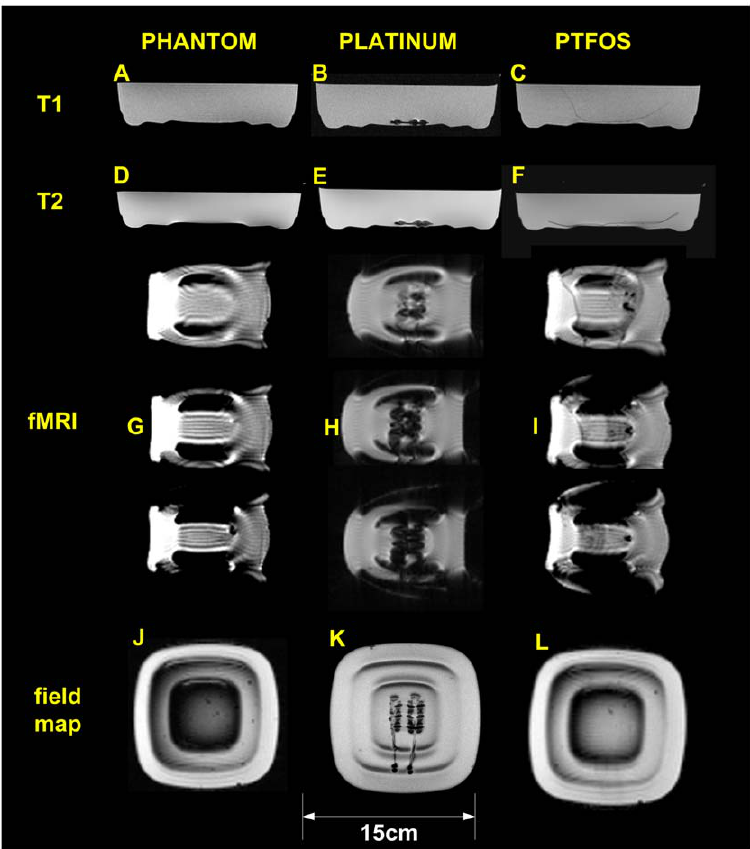
Figure 3. The Magnetic Resonance Imaging testing. T-1 weighted MPRAGE of the: ( A ) phantom only, ( B ) Platinum subdural grid and ( C ) PTFOS. T-2 weighted MPRAGE of: ( D ) phantom only, ( E ) Platinum subdural grid and ( F ) PTFOS. Three consecutive central slices of BOLD images of: ( G ) phantom only, ( H ) Platinum subdural grid and ( I ) PTFOS. Fieldmap images of: ( J ) phantom only, (K) Platinum subdural grid and ( L ) PTFOS. Artifacts in the central column (platinum electrodes) are clearly visible in the central column.